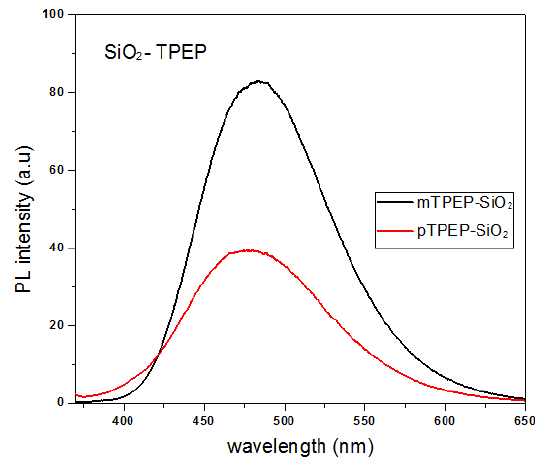
Figure 6. Emission spectra of mTPEP-SiO 2 and pTPEP-SiO 2 in water at excitation wavelengths of 355 and 333 nm, respectively. The concentration of silica nanoparticles in water is 2.0 mg/mL.